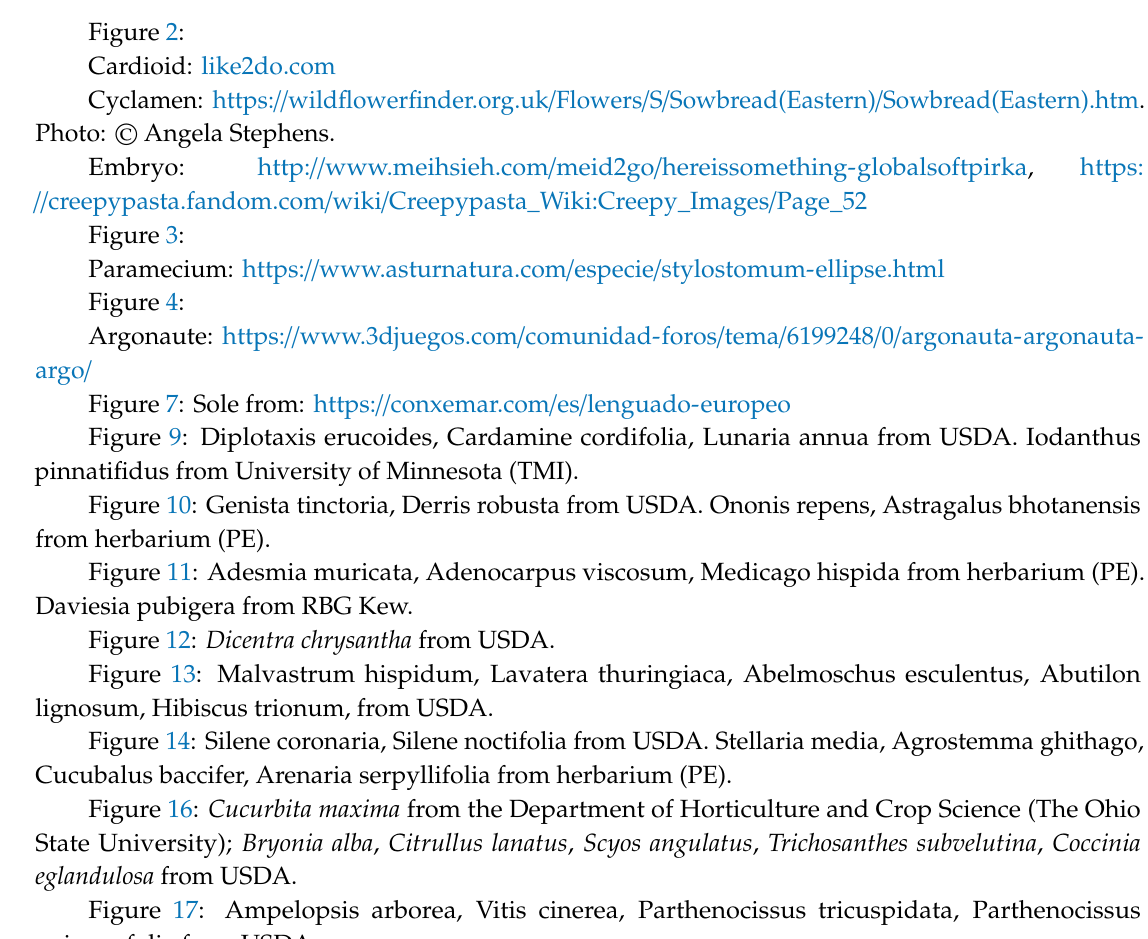
Figure 2: Cardioid: like2do.com Cyclamen: https: // wildflowerfinder.org.uk / Flowers / S / Sowbread(Eastern) / Sowbread(Eastern).htm. Photo: © Angela Stephens.